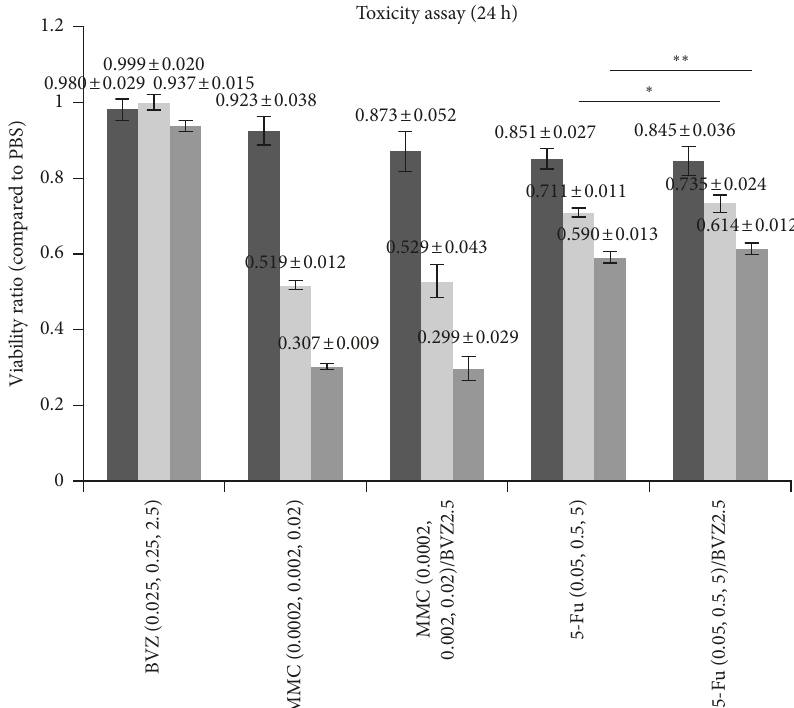
Figure 1: Cell viability of ARPE-19 after treatment with bevacizumab (BVZ), mitomycin C (MMC), 5-fluorouracil (5-Fu), MMC +BVZ, and 5-Fu+BVZ. The cell viability of the control group was set at 100%. Unit: mg/mL.